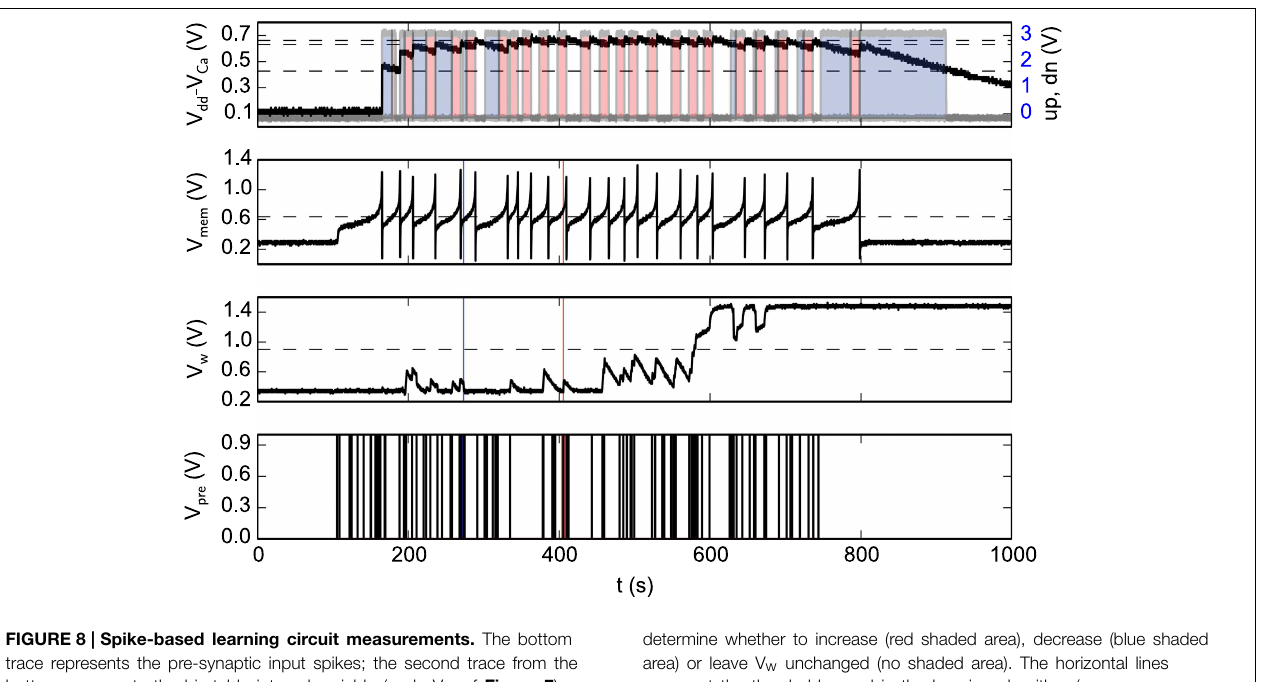
FIGURE 8 | Spike-based learning circuit measurements. The bottom trace represents the pre-synaptic input spikes; the second trace from the bottom represents the bi-stable internal variable (node V w of Figure 7 ); the third trace represents the post-synaptic neuron’s membrane potential; and the top trace shows both a voltage trace proportional to the neuron’s integrated spiking activity as well as the digital control signals that